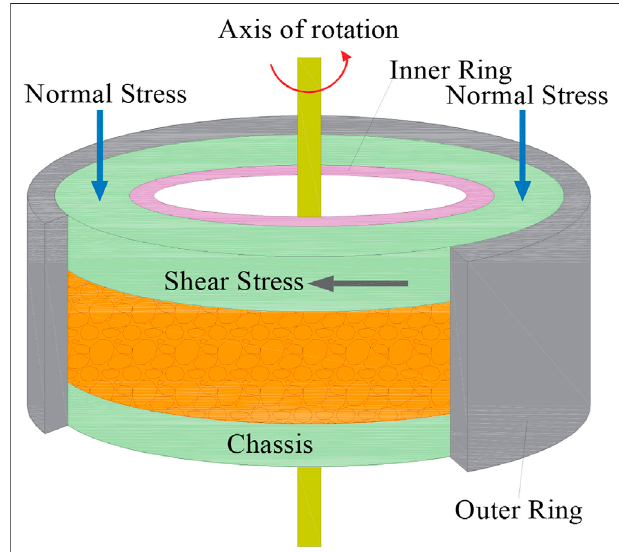
FIGURE 4 | Particle size distribution of slip zone